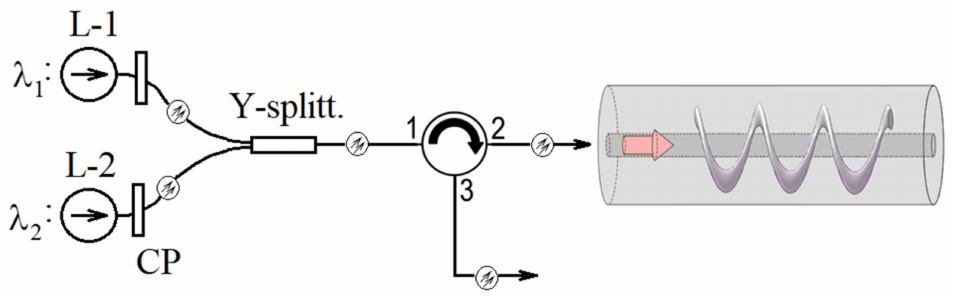
Figure 1. Scheme for generating a vortex signal using V-FBG on a RoF segment based on two emitting lasers (L-1 and L-2). CP devices are polarization controllers; Y-splitter is designed for summing optical signals into a